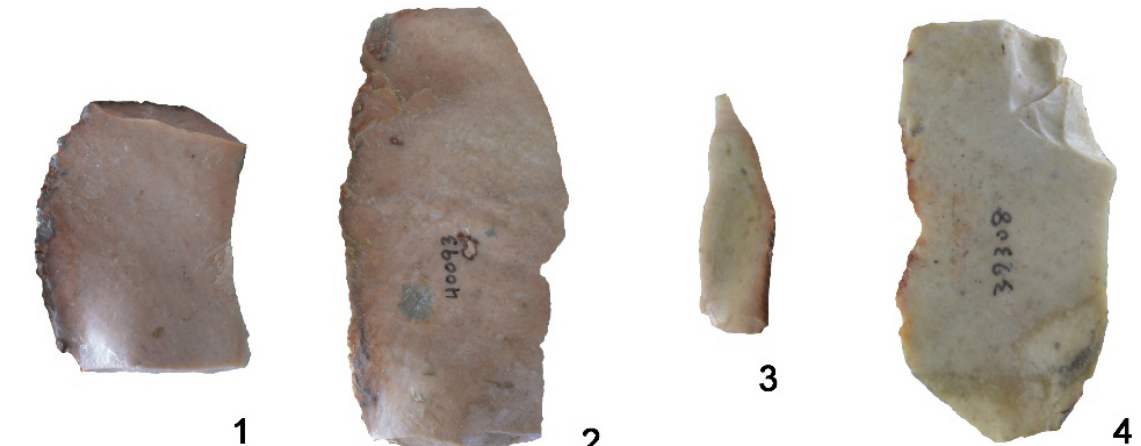
Figure 10. Comparison between the experimentally heat-treated samples and the archaeological artefacts. 1, 3: Experimental flakes flaked after heat treatment. 2, 4: Archaeological flakes recovered from Hasankeyf